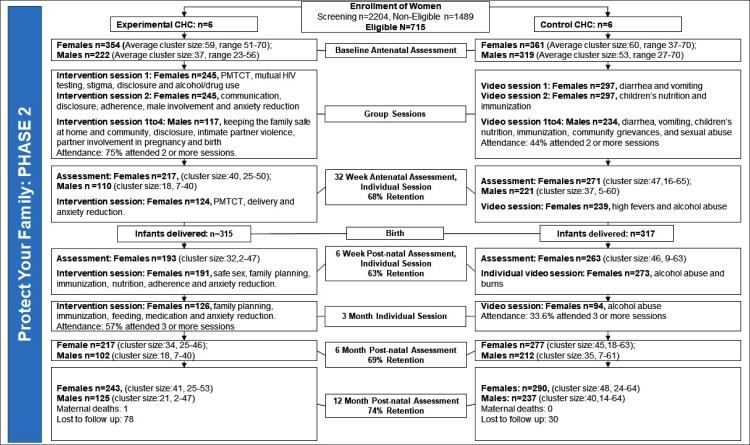
CONSORT diagram outlining enrolment procedures for Phase 2.